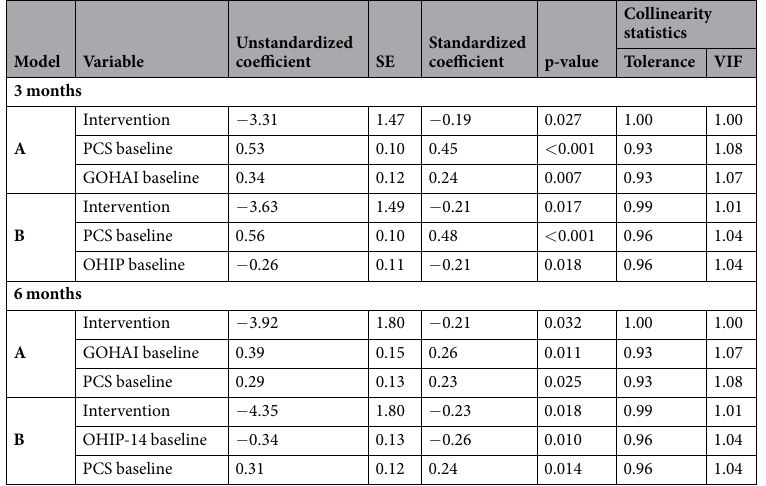
Table 4. Factors associated with PCS scores (linear regression model). 3-month final model: adjusted RP Psquare (model 3 a ) = 0.33; adjusted R square (model 3 b ) = 0.31. 6-month final model: adjusted RP